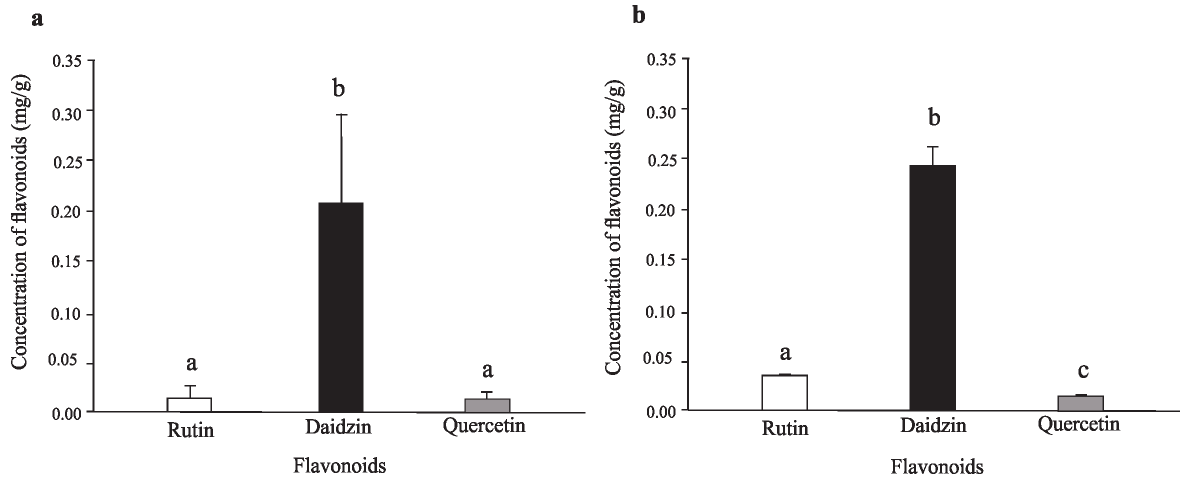
Figure 2 - Flavonoid concentrations in leaf extracts of the insect resistant soybean cultivars IAC-17 ( a ) and IAC-24 ( b ) mechanically damaged. Means followed by the same letter are similar between them by ANOVA (IAC-17 p<0.001 and IAC-24